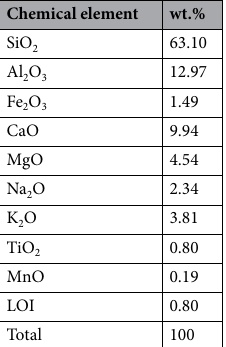
Table 2. Composition of the granite-based geopolymer.